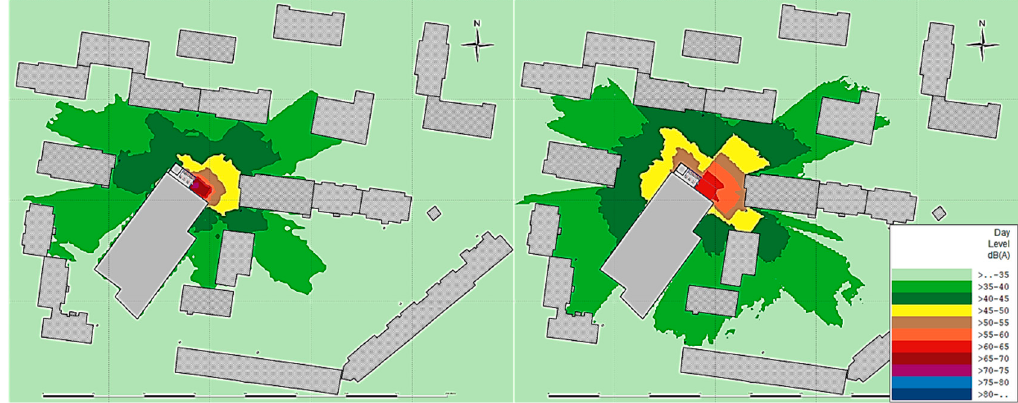
Figure 9. Scenario 5 with a supply ramp inside a construction and acoustic barriers on the roof—Lday with all noise sources ( left : 4 m, right : 10 m). with all noise sources ( left : 4 m, right : 10 m).